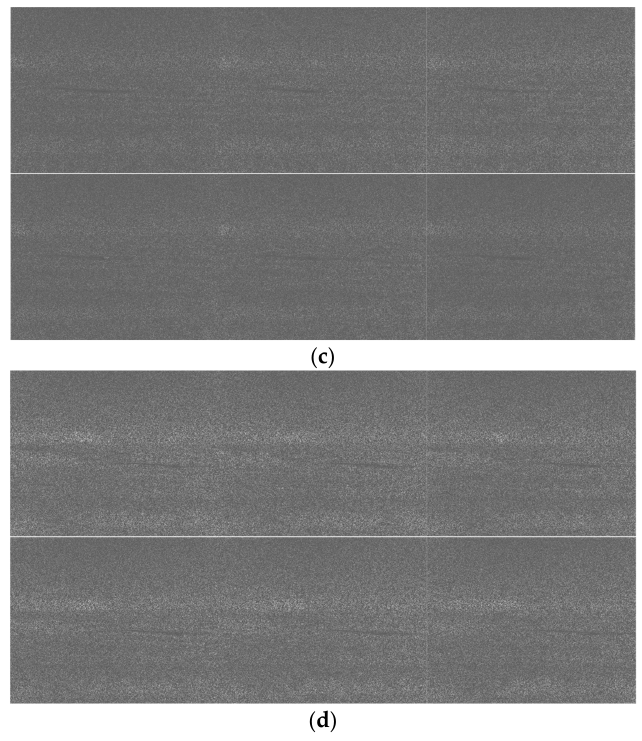
Figure A6. Tracking results for frames 1, 60, 119, 178, 237, and 296 for the PCE 25 (MWIR nighttime) case. The vehicle is SUV. ( a ) 1000 m; ( b ) 2000 m; ( c ) 2500 m; and ( d ) 3500 m.